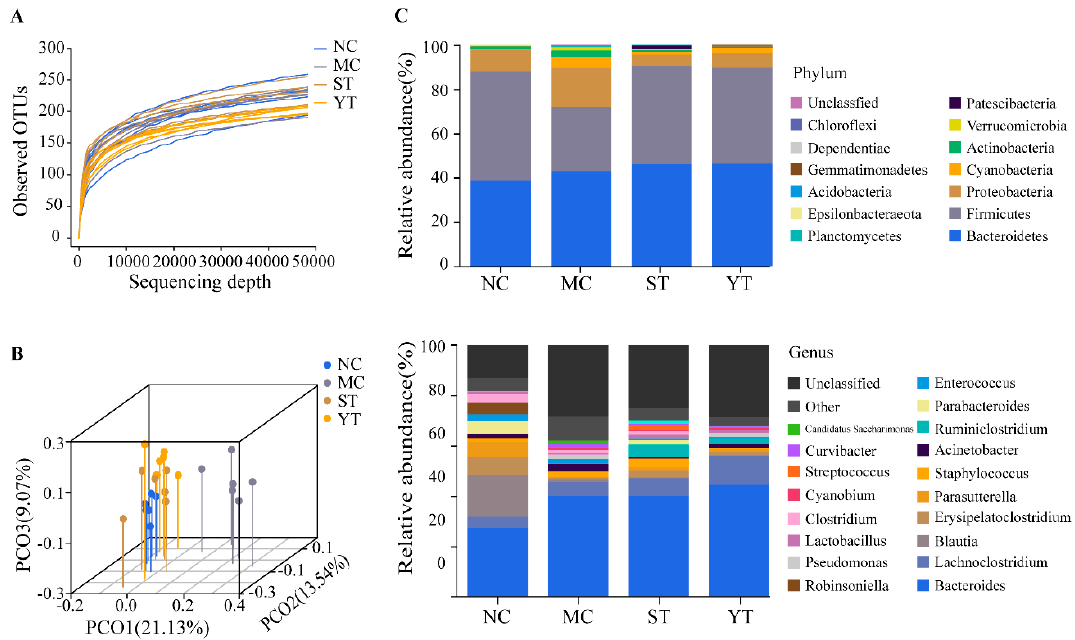
Figure 7. Diversity and composition of Intestinal microbiota in the NC, MC, ST and YT groups. ( A ) Rarefaction curves of observed OTUs for each sample. ( B ) Principal Coordinate Analysis (PCoA) by UniFrac (unweighted) of microbiomes. ( C ) The composition of gut microbiota at the phylum (up) and genus (down) levels. NC, Normal control group ( n = 6); MC, Model control group ( n = 6); ST, DMST-H2 treatment group ( n = 6); YT, yogurt treatment group ( n = 6).